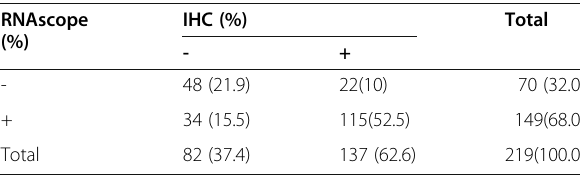
Table 3 Crosstabulation of UPK2 status detected by IHC